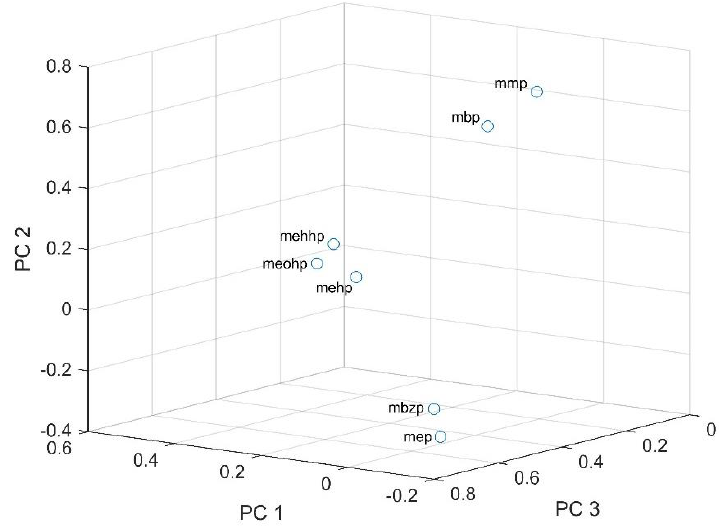
Figure 2. Principal component analysis (PCA) of the levels of the seven phthalate metabolites detected in urine samples from Iranian children and adolescents.